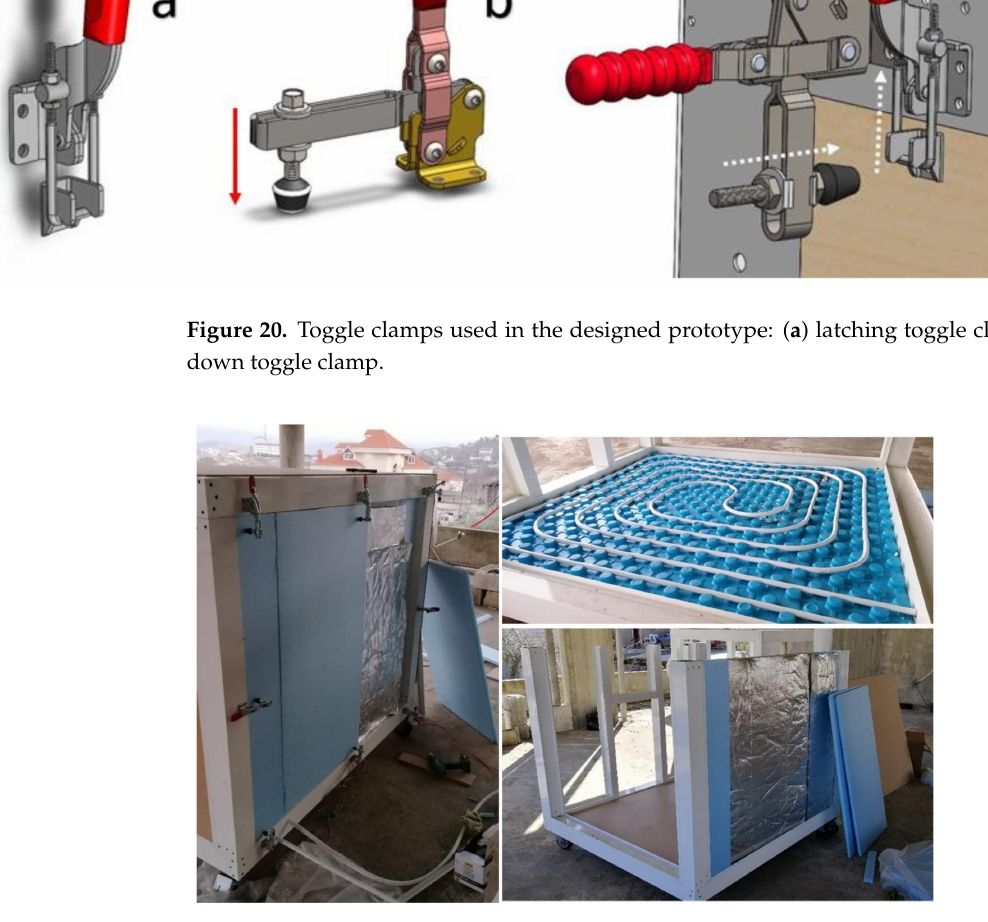
Figure 21. Real pictures showing different installed components in the implemented